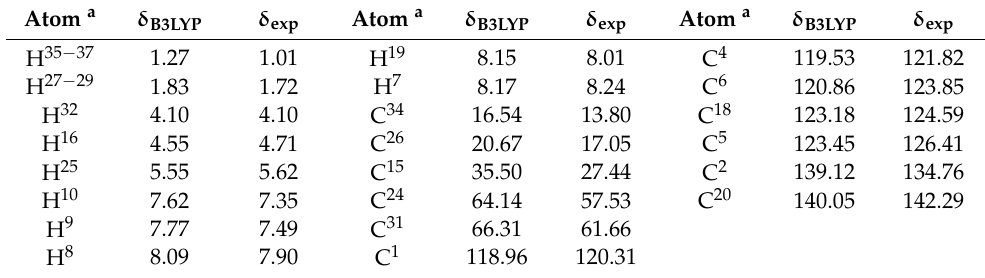
Table 2. B3LYP/6-31 + G(d, p ) calculated and experimental 1 H and 13 C chemical shifts (in ppm) of 5e in DMSO.